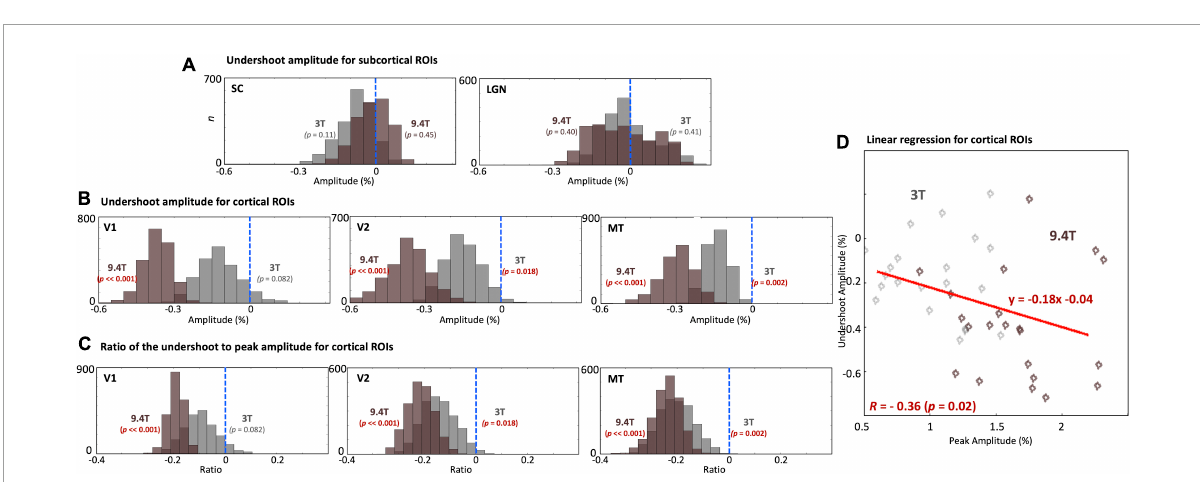
FIGURE7 (A) Histograms of the undershoot amplitude across subjects in SC and LGN. No significant undershoot was found. (B) Histograms of the undershoot amplitude. (C) The ratio of the undershoot to peak amplitude across subjects in V1, V2, and MT. While significant differences of the undershoot amplitude between 9.4T and 3T were found, no significant difference was found for the ratio of the undershoot to peak amplitude between field strengths. The blue dashed vertical lines show the baseline of the HRF. (D) Linear regression between peak amplitude and corresponding undershoot amplitude for cortical ROIs. Each point represents mean peak and undershoot amplitudes for one subject.